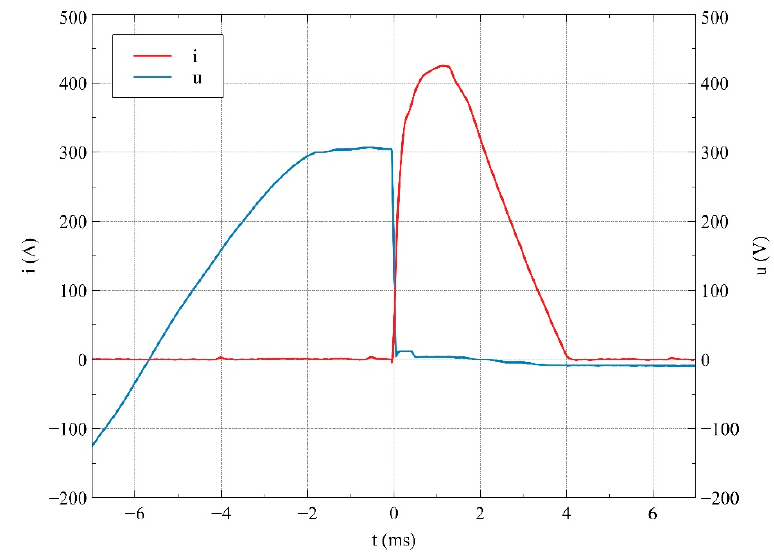
Figure 4. Current and voltage waveforms for a selected test for voltage phase Φ = 90 ◦ ; contact material is AgSnO 2